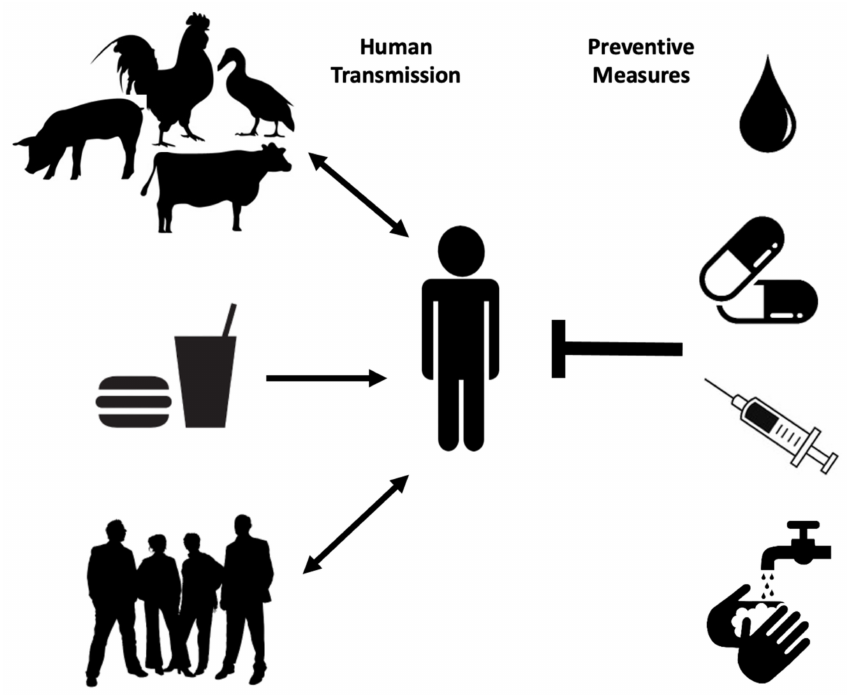
Figure 1. Transmission and prevention of Salmonella infections. Human transmission of Salmonella primarily occurs through ingestion of contaminated food or water, contact with infected animals or animal feed and person-to-person transmission. Dual arrows are shown between humans and animals because transmission can occur in both directions. The best preventive measures to reduce the incidence of human infections include proper sanitation, treatment of infected individuals, vaccination (when possible) and access to clean